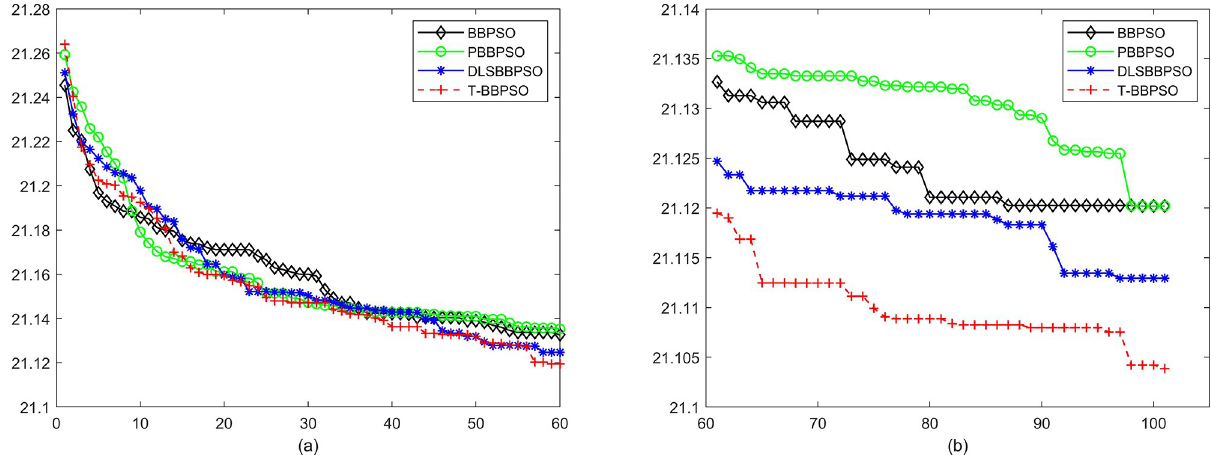
Fig 7. Comparison of convergence speed between BBPSO, PBBPSO, DLS-BBPSO and TBBPSO, f 5 , (a) iteration 0–6000, (b) iteration 6000–10000 the unit is 100 iteration.